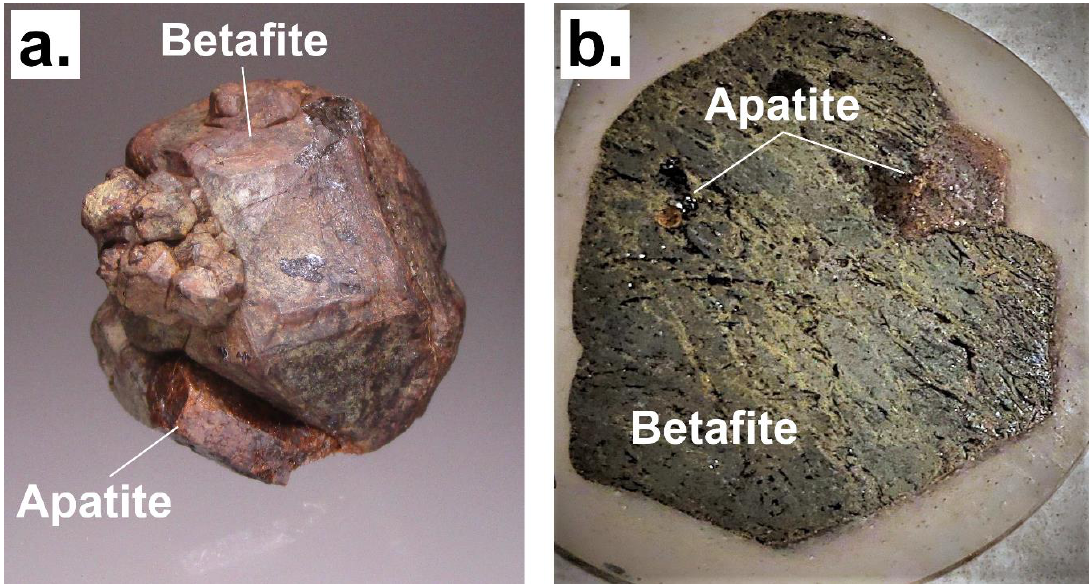
Figure 4. ( a ) A 3 cm betafite crystal with intergrown fluorapatite. ( b ) Section taken through the sample in ( a ) showing both intergrown and included apatite crystals.